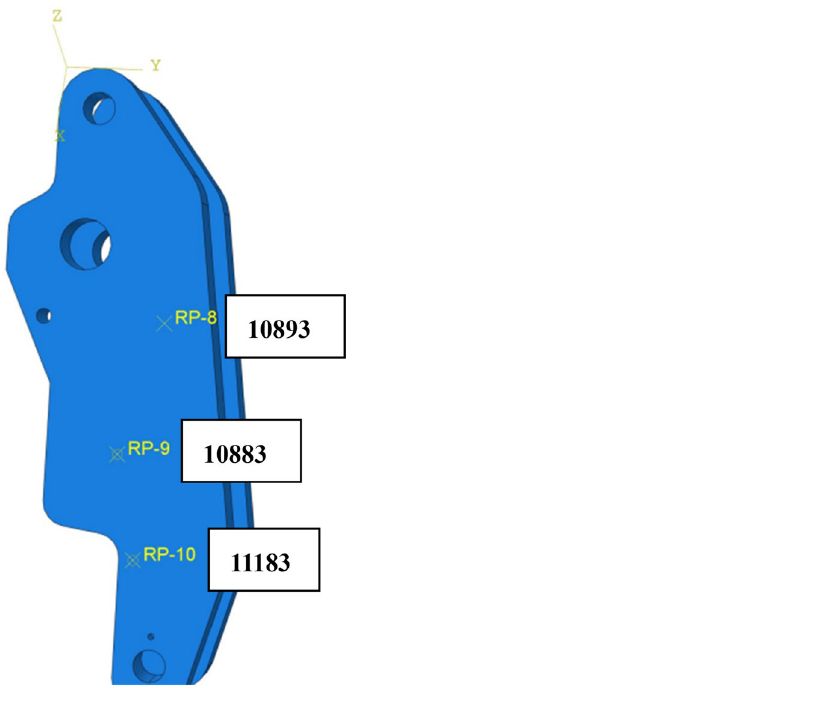
Figure 9. Position of the brake arm selected points and nodes number (Abaqus